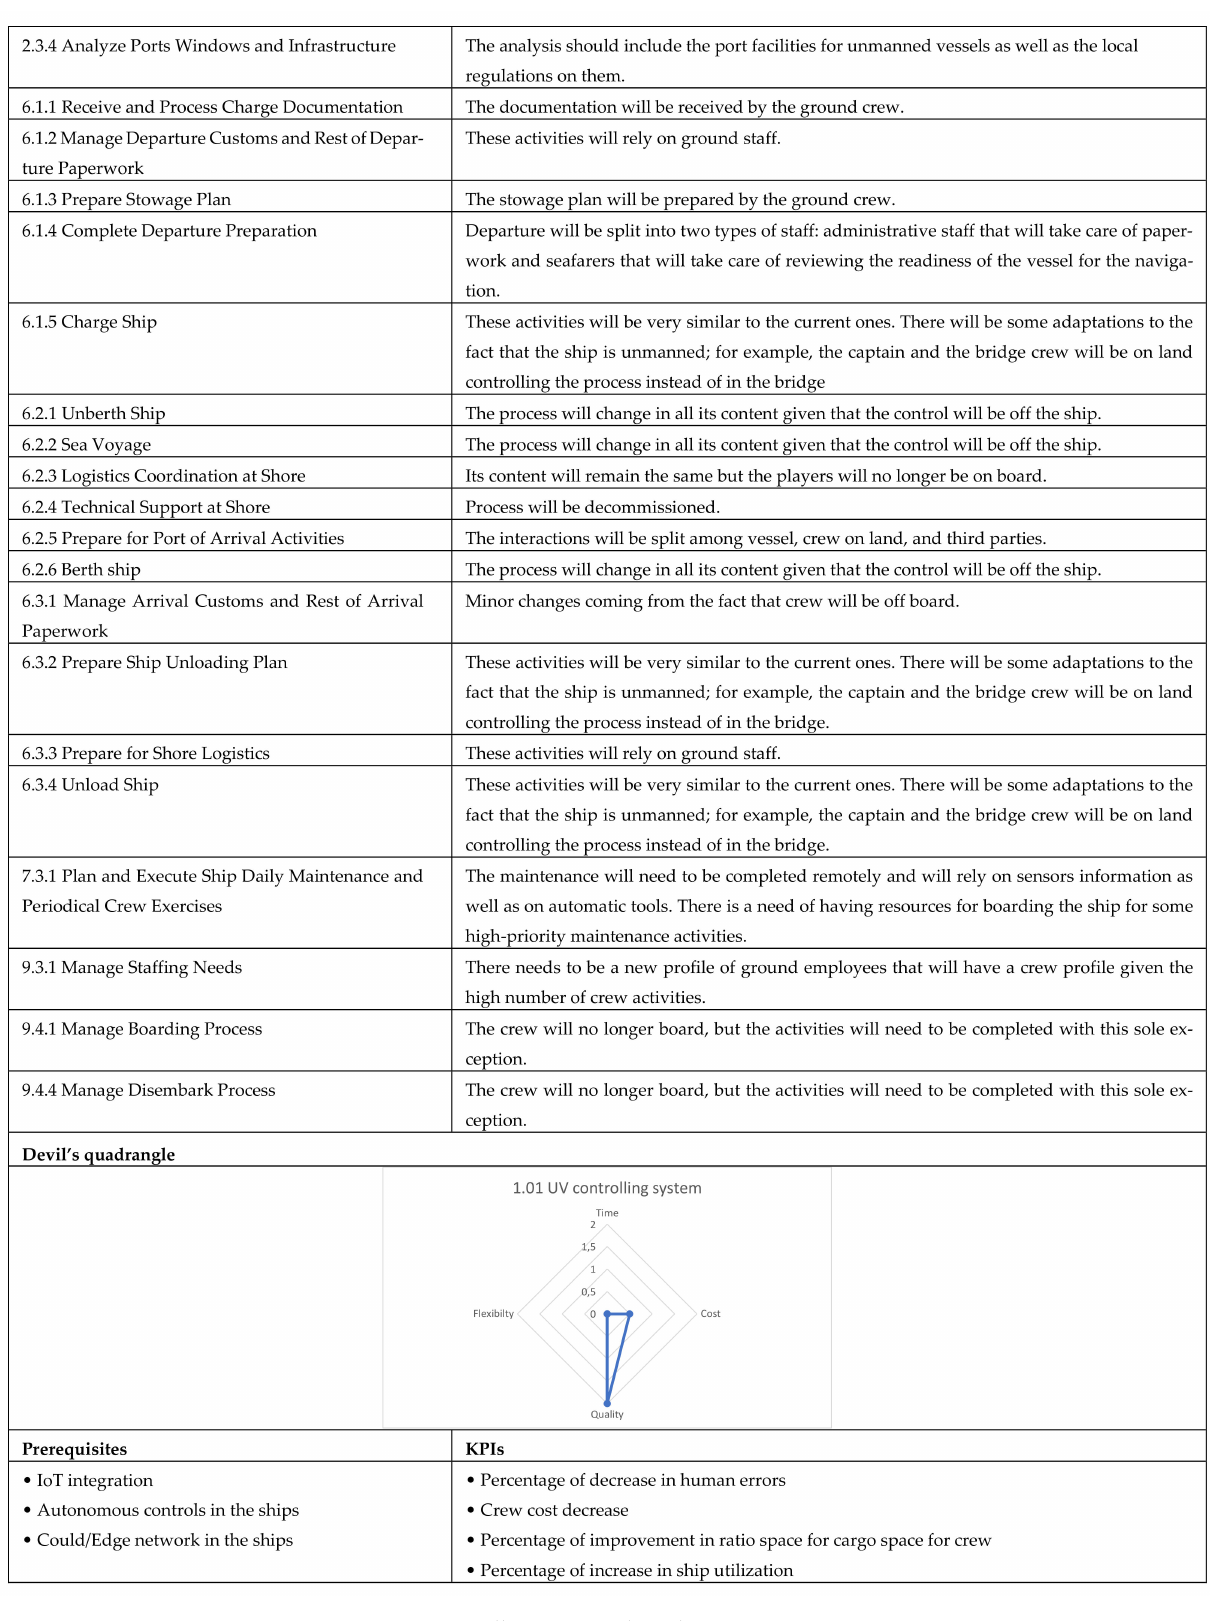
Figure A1. UV controlling system data